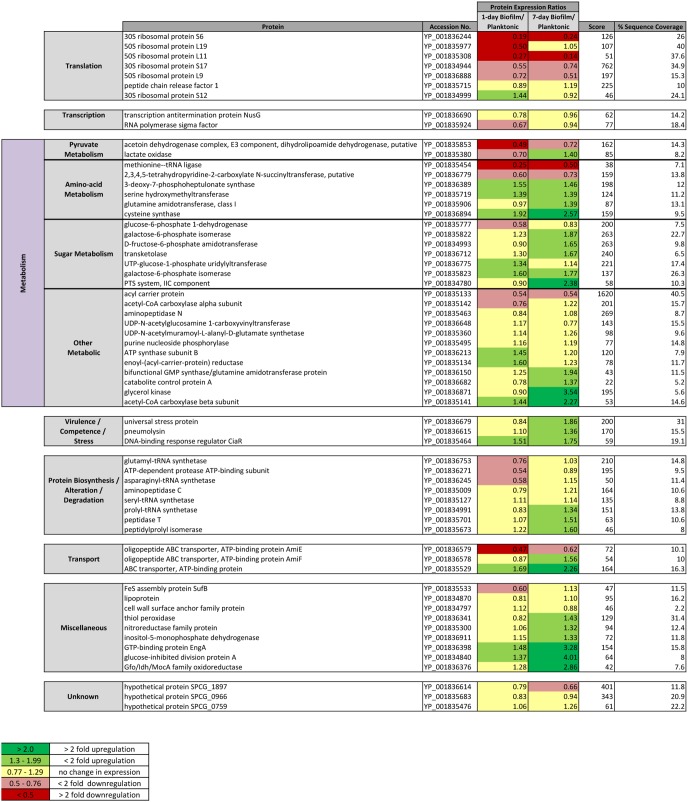
Qualitative data listing proteins identified with 2 peptide matches using comparative iTRAQ analysis of S. pneumoniae serotype 14 1-day and 7-day old in vitro biofilms to planktonic population protein expression.Comparative protein data with >1.3 and <0.77 ratios identified as having differential expression.